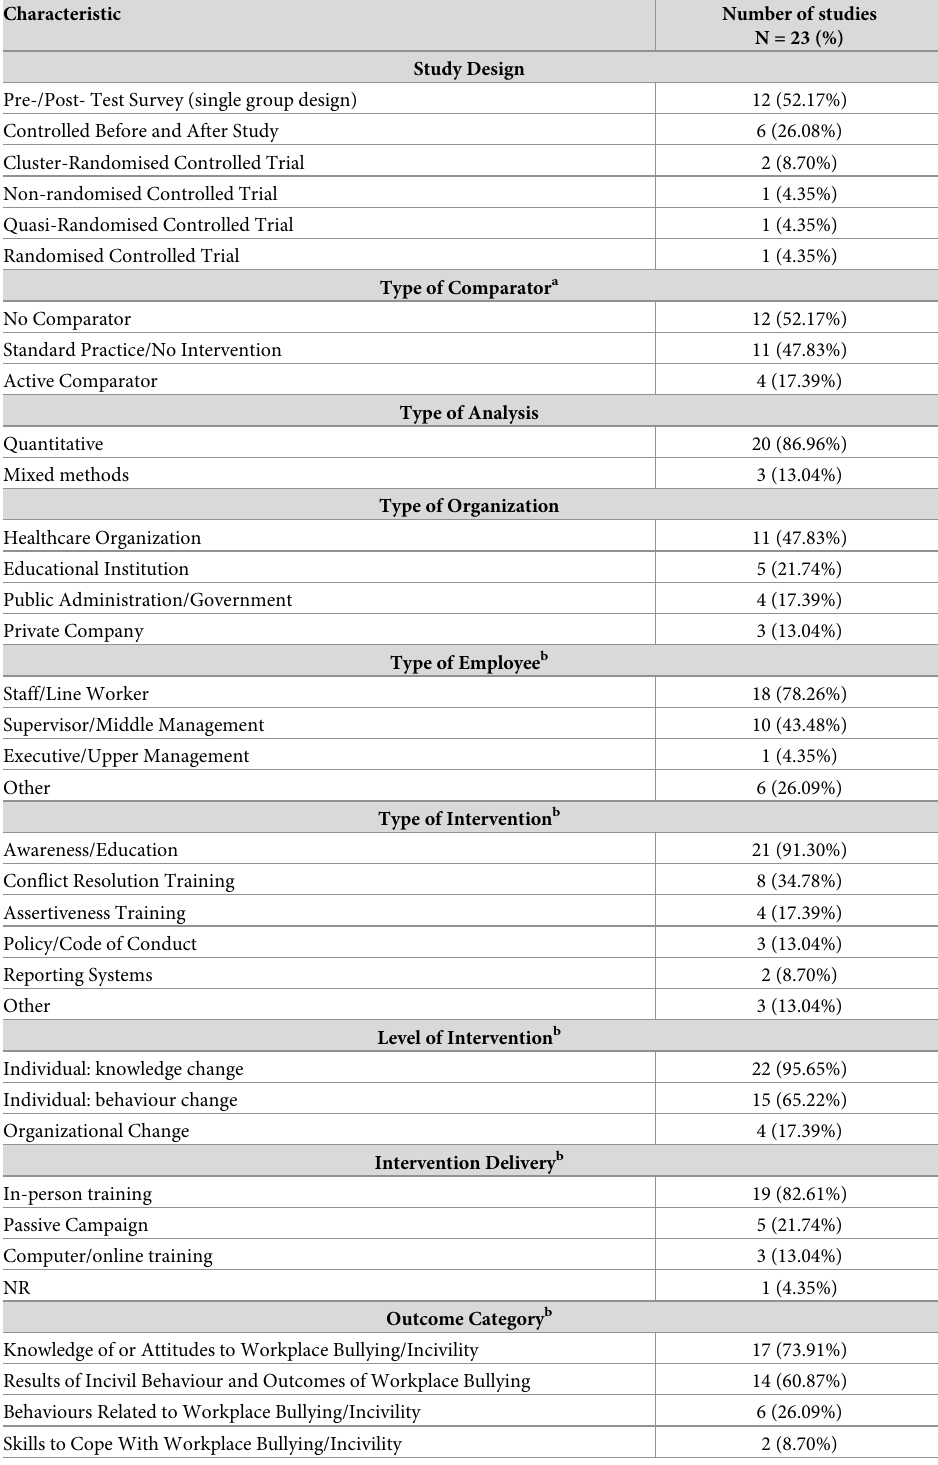
Table 1. Summary study